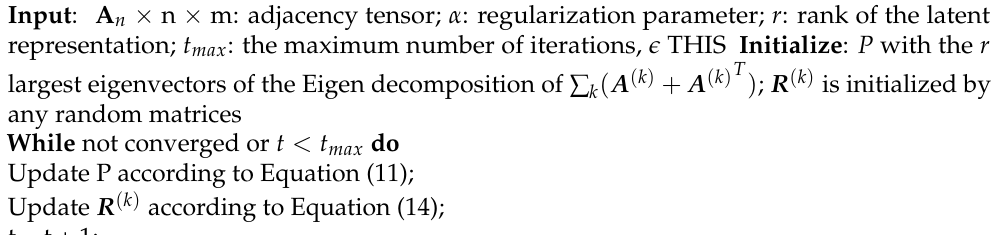
Algorithm 1 Algorithm of